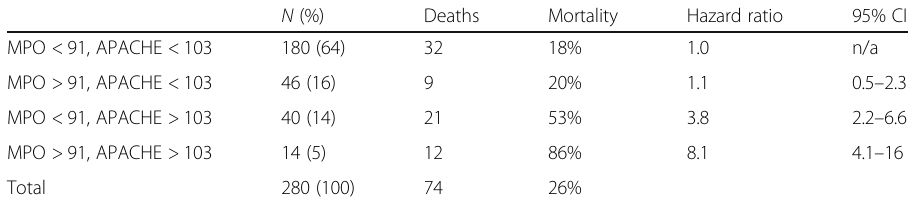
Table 2 Mortality risk and hazard ratios N (%) Deaths Mortality Hazard ratio 95% CI MPO < 91, APACHE < 103 180